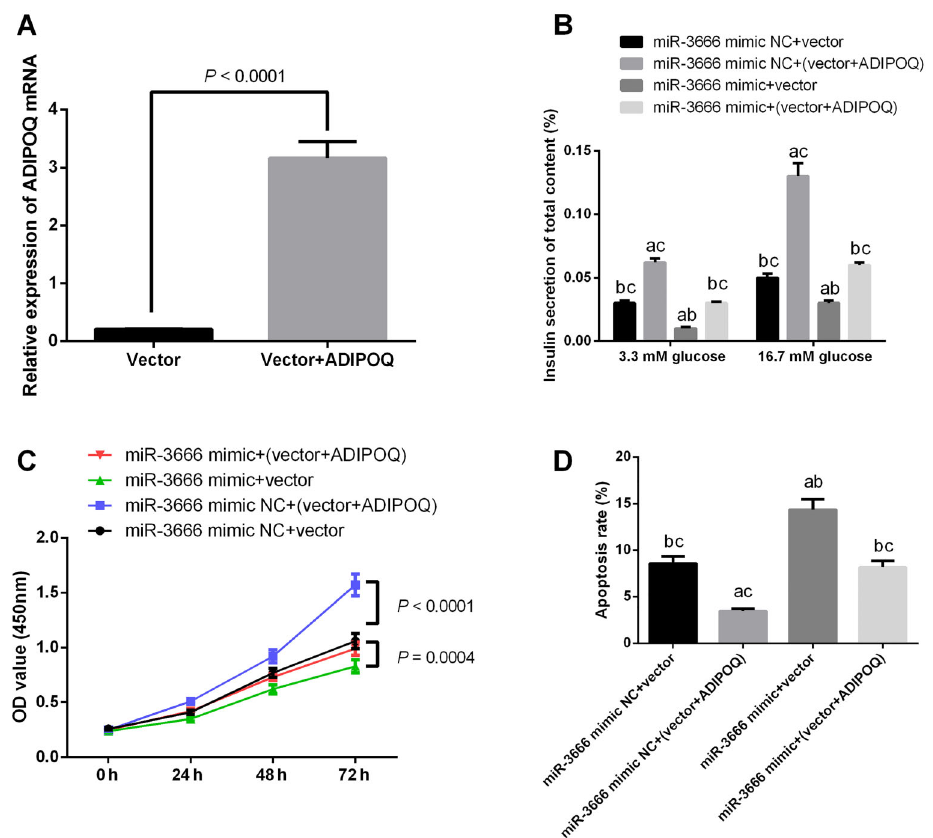
Figure 4. ADIPOQ was involved in the miR-3666-mediated effects on the functions of pancreatic b -cells. A , INS-1 cells were transfected with pcDNA3.1 (vector) or pcDNA3.1-ADIPOQ (ADIPOQ), and the mRNA expression of ADIPOQ was determined by qRT-PCR. INS-1 cells were co-transfected with pcDNA3.1-ADIPOQ (or pcDNA3.1 vector) and miR-3666 mimic (or mimic-normal control (NC)). B , Glucose-stimulated insulin secretion was determined by ELISA assay. C , Cell proliferation was determined by MTT assay. D , Cell apoptosis was determined by fl ow cytometry. a P o 0.05 compared to miR-3666 mimic NC + vector; b P o 0.05 compared to miR-3666 mimic NC + (vector + ADIPOQ); c P o 0.05 compared to miR-3666 mimic + vector. Data are reported as means ± SE (n=3) and were compared with the t -test or